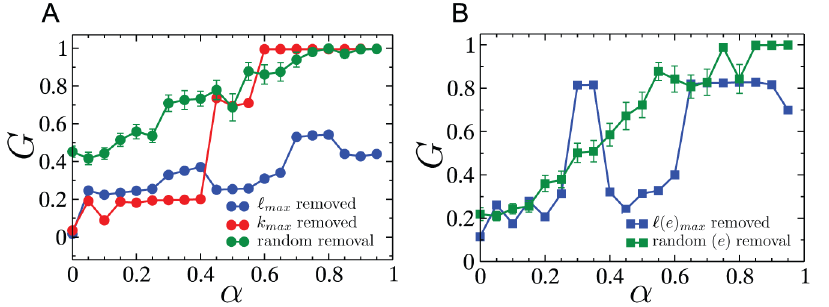
Figure 12. Cascades on the UCTE network. (A) Cascades triggered by the removal of a single node where the node was chosen using three different criteria i.e. randomly, highest load or highest degree. (B) Cascades triggered by the removal of a single edge where the edge was either chosen randomly or was the one with the highest load. Data obtained for cascade triggered by the random removal of a single node (edge) were averaged over 100 different scenarios.